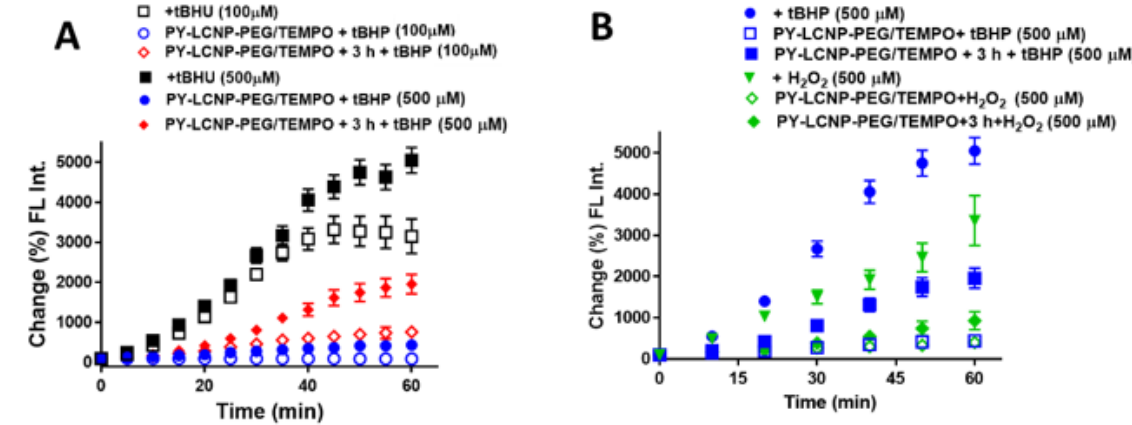
Figure 4. Quantification of the intracellular ROS-scavenging efficiency of PY-LCNP-PEG/TEMPO . ( A ) Time-resolved quantification of H2DCFDA, which measures ROS activity and shows the change (%) of ROS level in the cells induced by incubation with 100 µ M and 500 µ M of tBHP with or without PY-LCNP-PEG/TEMPO pre-labeling immediately or after a 3 h incubation. The data for each sample were derived from the emission intensity of the individual cells (50–80 of cells) from three independent experiments ( n = 3 ± SEM) and are normalized to the emission intensity at the beginning of the imaging. ( B ) A comparative quantification of ROS level in the cells induced with 500 µ M of tBHP and H 2 O 2 with or without PY-LCNP-PEG/TEMPO pre-labeling immediately or after 3 h